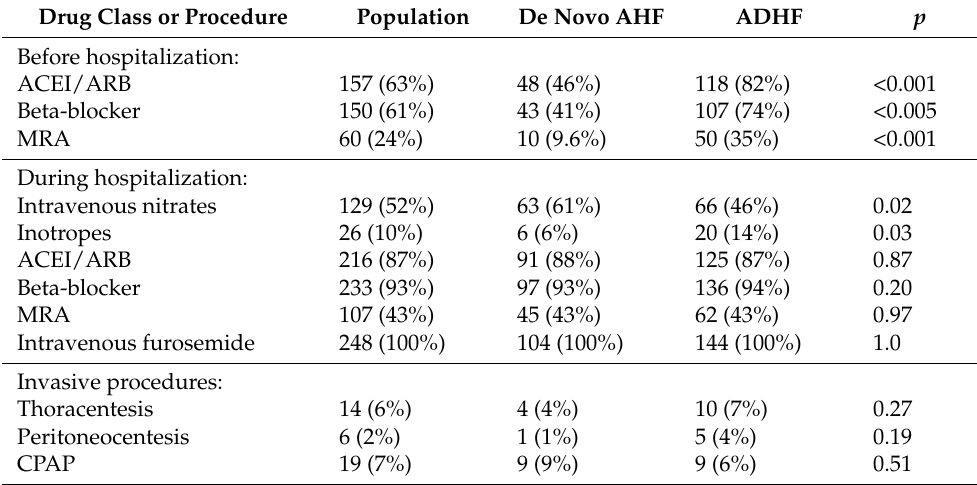
Table 2. Administered drug class and invasive